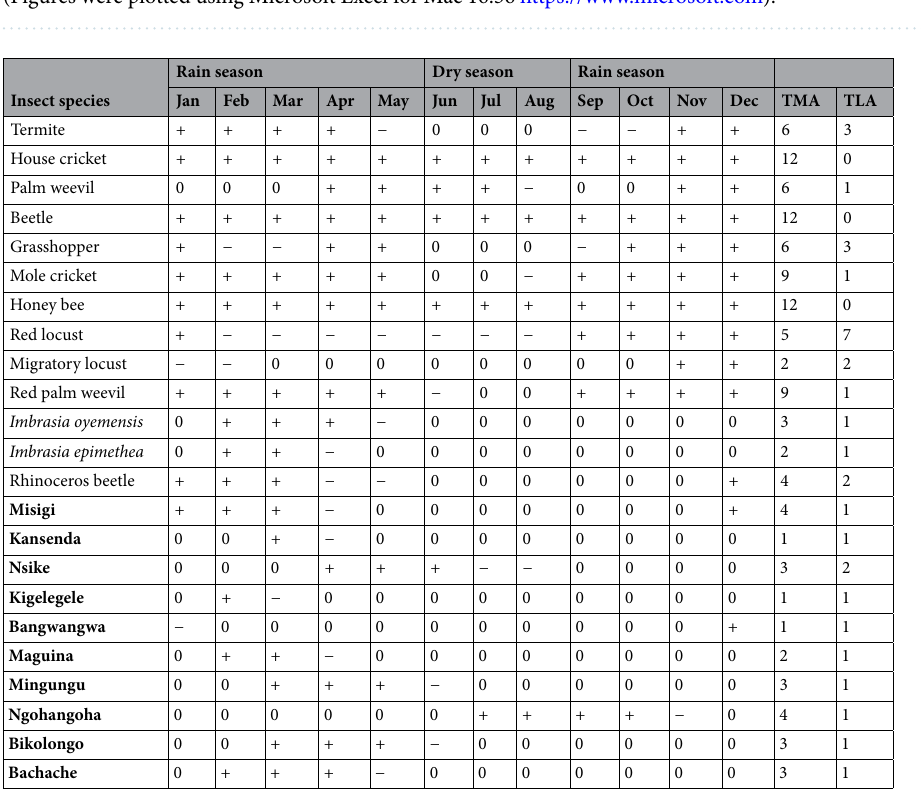
Table 3. Seasonal availability of various inventoried edible insects. + month of availability, − month of less availability, 0 month of none availability, TMA Total month of availability, TLA Total month of less availability.